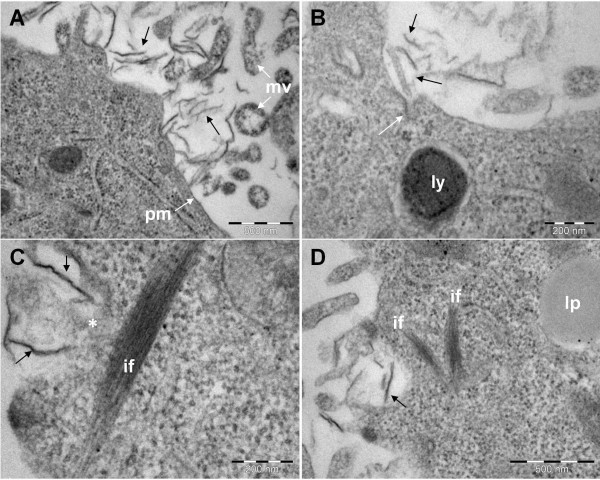
Interaction CXYG nanoplatelets with the plasma membrane. (A) SEM micrograph showing the interaction of CXYG nanoplatelets (exemplarily indicated by black arrows) with the plasma membrane (pm) and microvilli (mv). (B) Vesicle formation (white arrow) at the site of interaction of CXYG nanoplatelets (black arrow) with the plasma membrane. (C) and (D) CXYG nanoplatelets (black arrows) interacting with the plasma membrane and penetrating the latter (C) leading to plasma membrane disruption (the site of disruption is indicated with a white asterisk). Thick intermediate filament bundles (if) are present at the site of injury. Scale bars represent 500 nm in (A) and (D), and 200 nm in (B) and (C). Other cellular structures indicated in Figure nine: lp: lipids, ly: lysosomes.